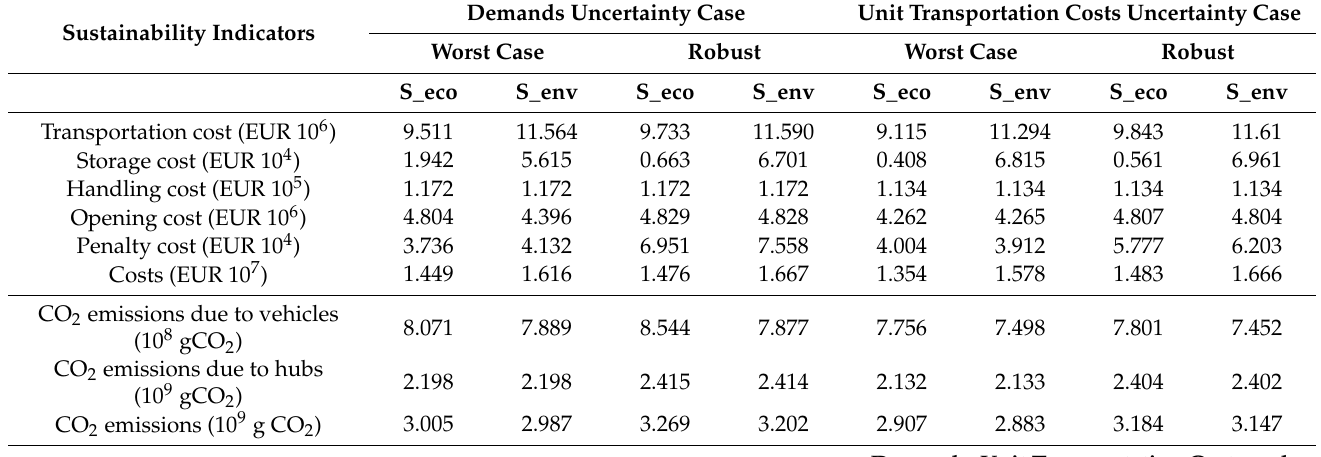
Table 6. Summary of the results obtained in the worst case and the robust